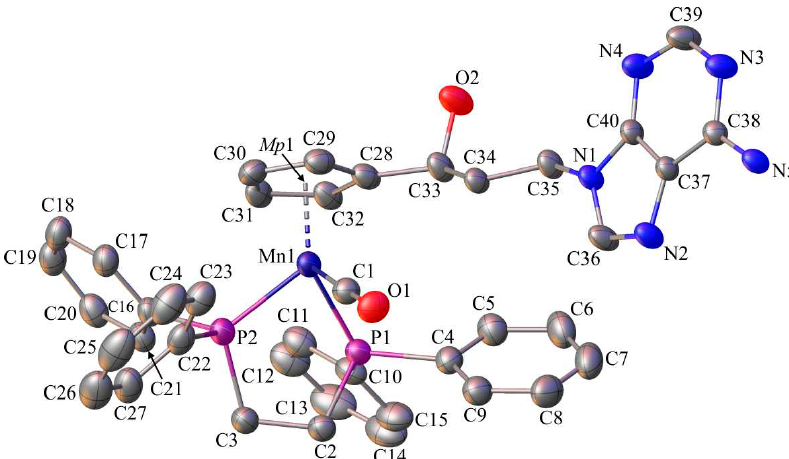
Figure 3. The molecular diagram of C with atomic displacement ellipsoids at the 50% probability level; Mp1 corresponds to mid-point of the cyclopentadienyl ring. Hydrogen atoms and solvent molecules have been omitted for clarity. Selected bond lengths [Å] and angles [°]: Mn1-C1, 1.760(3);